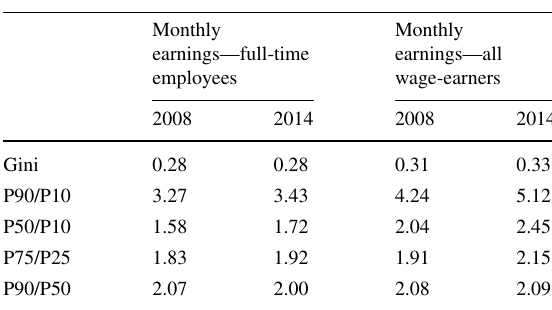
Indicators of inequality in monthly earnings Monthly earnings—full-time